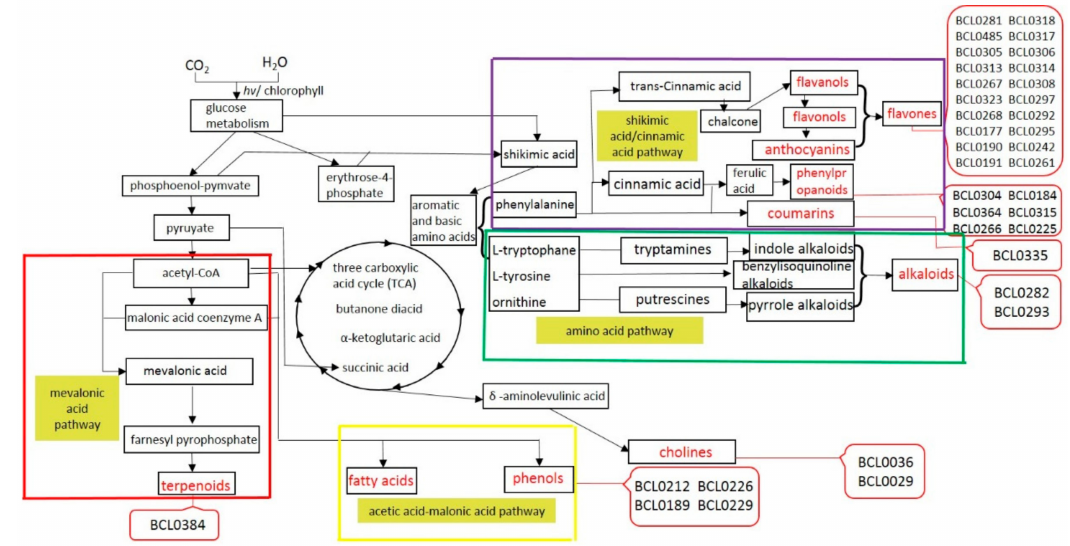
Figure 8. The relationship of different metabolic pathways. Important primary metabolic precursors and intermediate secondary metabolites are shown in black font, the final secondary metabolites are shown in red font. Pathways are boxed as follows: red box, mevalonic acid pathway; purple box, shikimic acid/cinnamic acid pathway; green box, amino acid pathway; yellow box, fatty acid pathway. The red callout boxes refer to the index number of up-regulated secondary metabolites, as detailed in Table